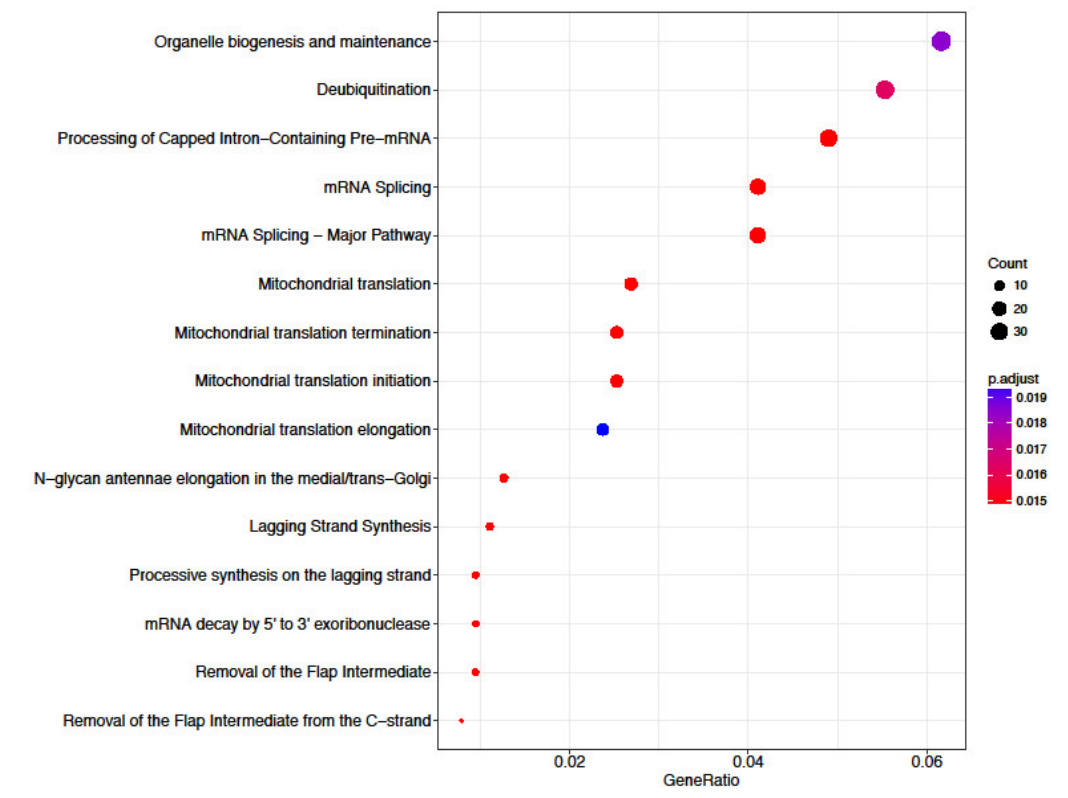
Figure 3. Pathway dot plot of gene expression profiles in between the biopsied embryo groups.